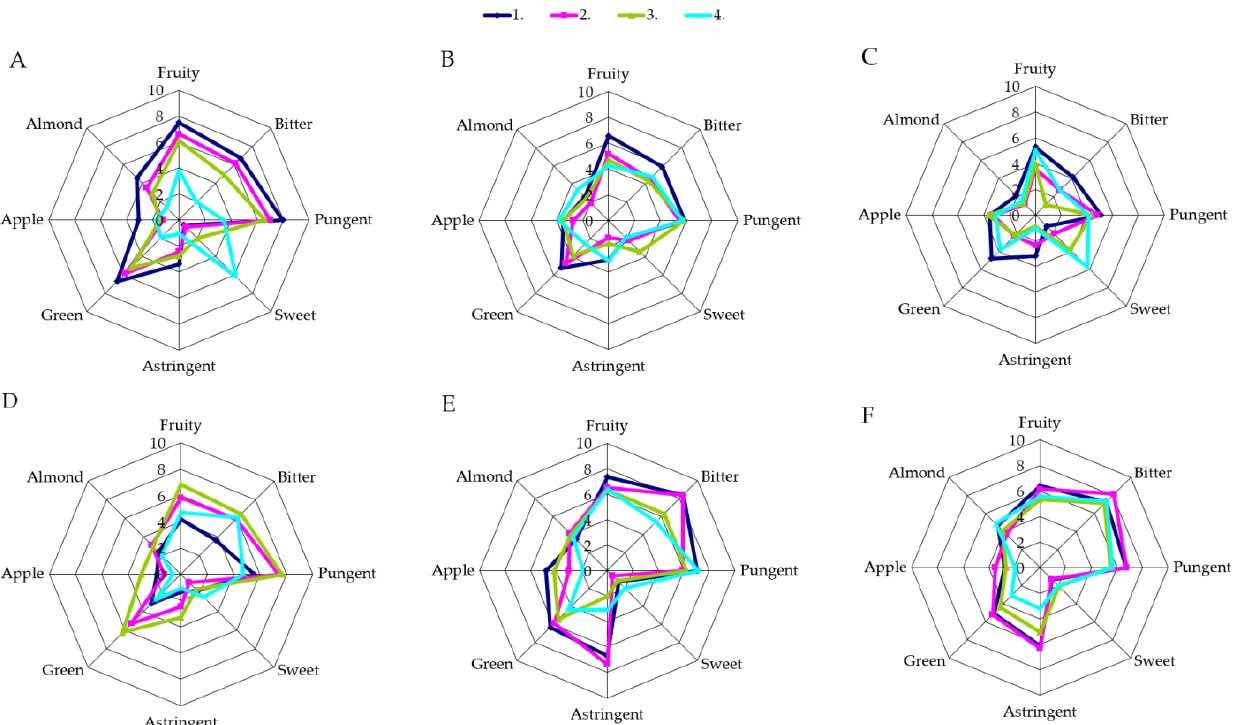
Figure 3. Sensory profile of Oblica virgin olive oils obtained in 3 successive crop years from the 2 distinct olive orchards at 4 harvest periods. ( A )—Kaštela 2010, ( B )—Kaštela 2011, ( C )—Kaštela 2012; ( D )—Šetanovac 2010, ( E )—Šetanovac, 2011, ( F )—Šetanovac 2012; 4 harvest periods—line colors 1–4 within each graph.